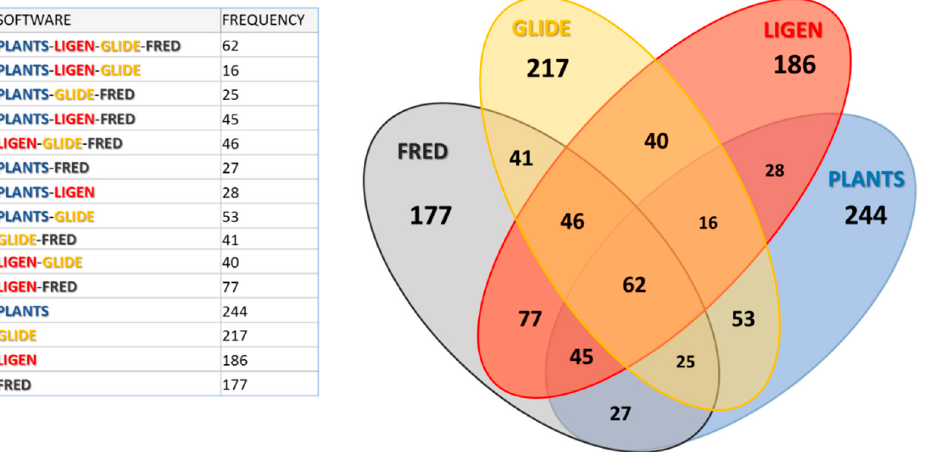
Figure 4. Venn diagram representing the overlapping degree between the Top 500 molecules as derived by applying the best equations developed for each docking software. A table detailing the resulting frequencies is also included (the color code for the four docking tools is the same adopted in Figure 1).